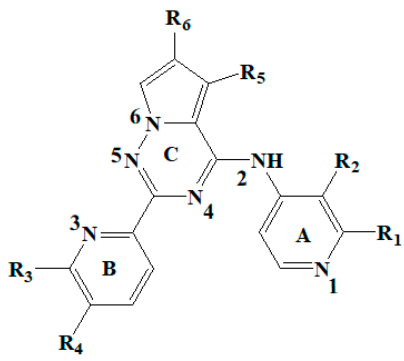
Figure 1. Structure of compounds with a pyrrolotriazine-like backbone as TGF- β type 1 receptor (T β R1) inhibitors; the three rings are labeled A, B, and C, and the nitrogen atoms are specified as 1, 2, 3, 4, 5, and 6.